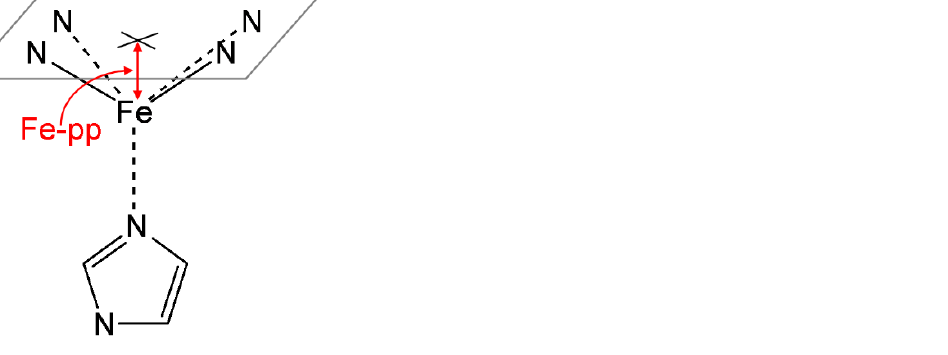
Figure 2. Iron out-of-plane distance (Fe–pp), defined as the distance between the plane determined by the four pyrrole nitrogen atoms and the iron.